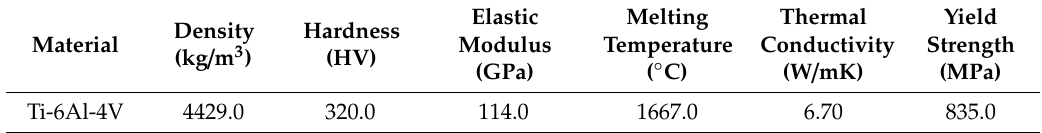
Table 1. Physical and mechanical properties of Ti-6Al-4V alloy at room temperature.